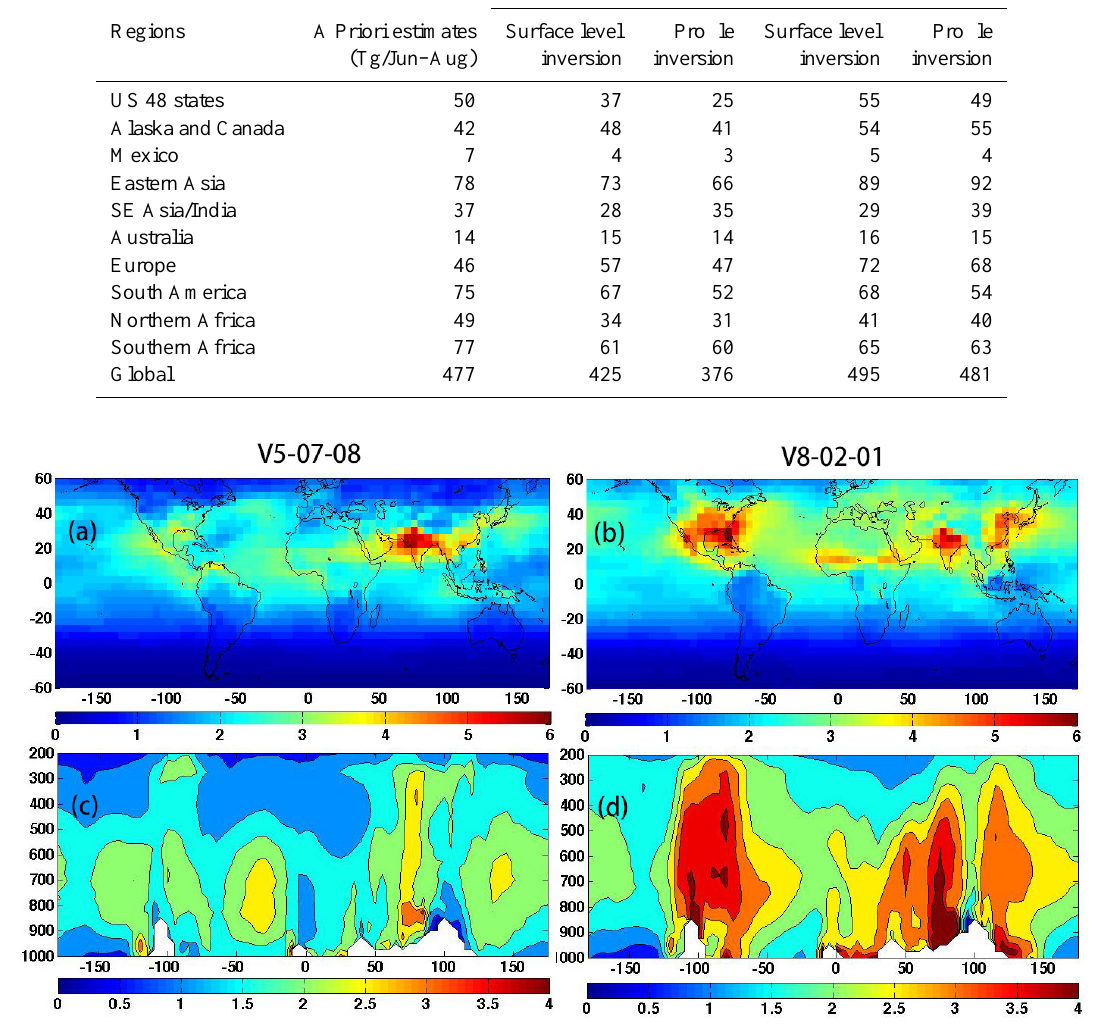
Figure 6. (a, b) : Mean tropospheric OH column (10 12 moleccm − 2 ) in July 2004; (c, d) : Meridional mean OH concentration (10 6 moleccm − 3 ) between 20–40 ◦ N in July